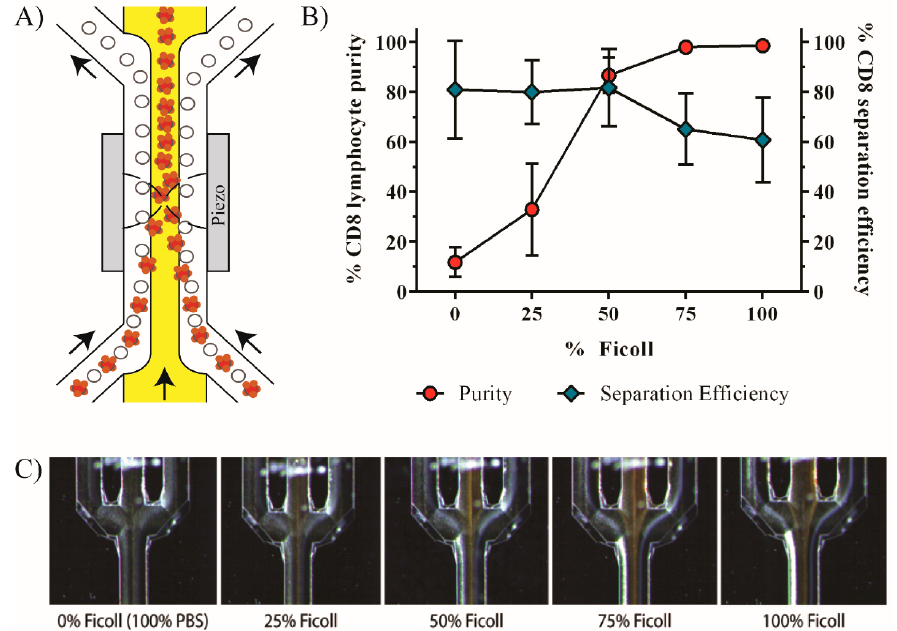
Figure 6. Purity and separation efficiency of acoustically sorted CD8+ cells in relation to the central buffer density. ( A ) Schematic drawing of the microfluidic device showing the effect of the high density central buffer. Bead-labeled cells (orange) and unlabeled cells (white) enter into the main separation channel. High density buffer infused in the central inlet (yellow) creates a barrier across which bead-labeled cells can be acoustically moved into the center stream and collected in the central outlet while unlabeled cells are not able to move into the high density buffer and thus exit the separation channel through the side outlet. Arrows indicate the flow direction; ( B ) Ficoll was diluted in PBS in different concentrations and used as central buffer. The purity of the acoustic separation as well as the separation efficiency was determined ( n = 3); ( C ) The image sequence of the central outlet illustrates the effect on the acoustic separation at increasing levels of Ficoll in the central buffer. The increase of the central buffer density creates a barrier through which bead-labeled cells (orange) are able to move whereas unlabeled cells (white) are not and remain at the sidewall to be collected through the side outlet.